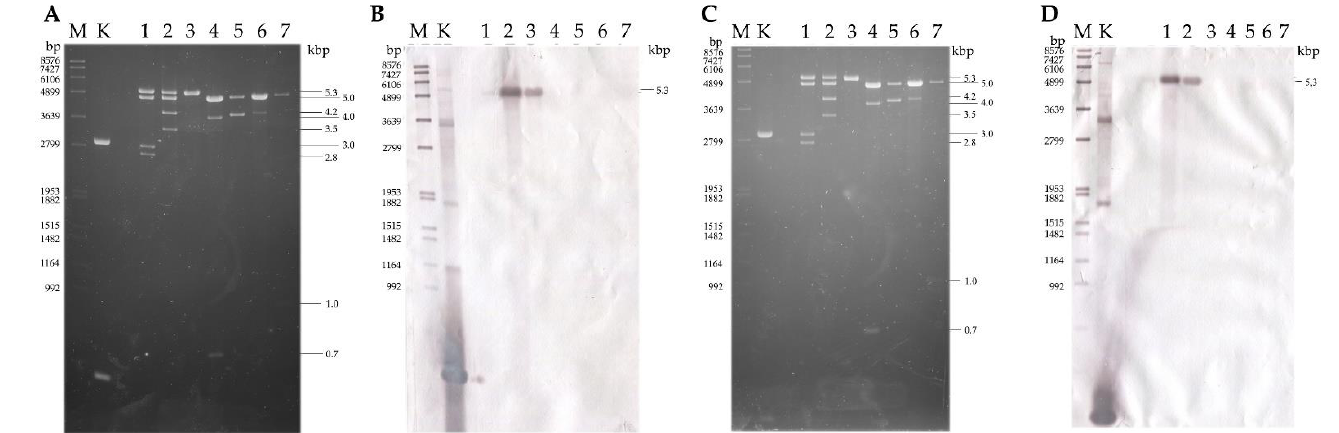
Figure 5. Northern blot analysis of dsRNA molecules purified from the mycovirus-harboring Umbelopsis ramanniana CBS 478.63 and CBS 243.58 strains using the UrV6a CP and RdRp probes, which were amplified with primers presented in Supplementary Table S2. Panels ( A , C ): agarose gel electrophoresis of the dsRNA molecules purified from the mycovirus-harboring Umbelopsis strains. Lane K, control plasmid containing the corresponding PCR amplicon of virus genomes; Lane M, DIG-labeled DNA Molecular Weight Marker VII (Roche Lane 1, Umbelopsis ramanniana NRRL 1296; Lane 2, Umbelopsis ramanniana CBS 478.63; Lane 3, Umbelopsis ramanniana CBS 243.58; Lane 4, Umbelopsis gibberispora CBS 109328; Lane 5, Umbelopsis angularis CBS 603.68; Lane 6, Umbelopsis dimorpha CBS detected dsRNA molecules. Panels ( B , D ): Northern blot analysis of the dsRNA molecules extracted from U. ramanniana CBS 478.63 and CBS 243.58 strains using the UrV6a/b CP and UrV6a/b RdRp probes, respectively. Both probes, the UrV6a/b CP ( B ) and the UrV6a/b RdRp ( D ) gave strong hybridization signals to the largest, 5.3-kbp band purified from the U. ramanniana CBS 478.63 and CBS 243.58 strains, as well as the Bgl II digested control plasmid, which contains the corresponding PCR amplicon of the UrV6a/b CP and UrV6a/b RdRp probe